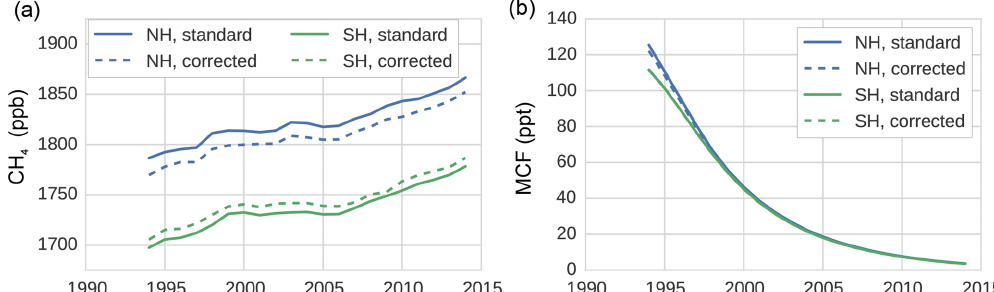
Figure 1. Hemispheric, annual mean time series of CH 4 (a) and MCF (b) , as derived from the NOAA surface sampling network (for CH 4 , 27 sites were used; for MCF, 12 sites were used). Solid lines denote averages as derived directly from the NOAA surface sampling network (which are used in our standard inversion). Dashed lines denote the same time series, but those that are adjusted by correction factors that were derived from our TM5 simulations. The correction factors reflect the differences between hemispheric averages based on model-sampled observations and hemispheric averages derived from the full TM5 troposphere. Figure 3 shows the ratios between the standard and corrected time series.